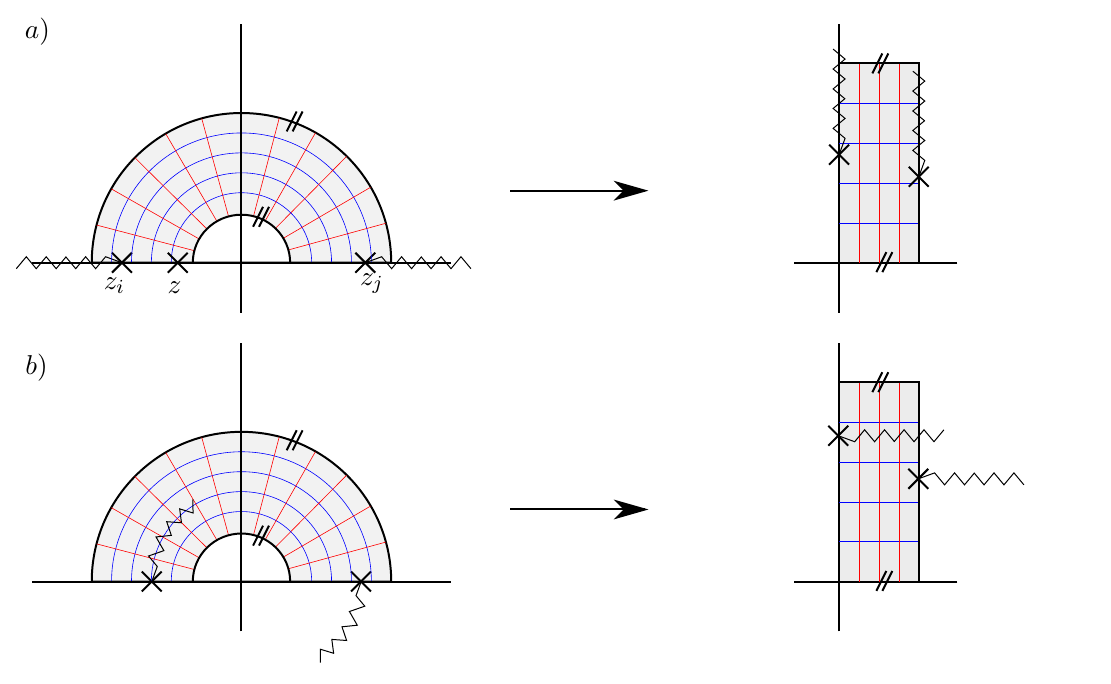
Figure 7 . Determination of the complex logarithm on the annulus. The choice in [20] is ( a ), whereas the convention of [31] is ( b